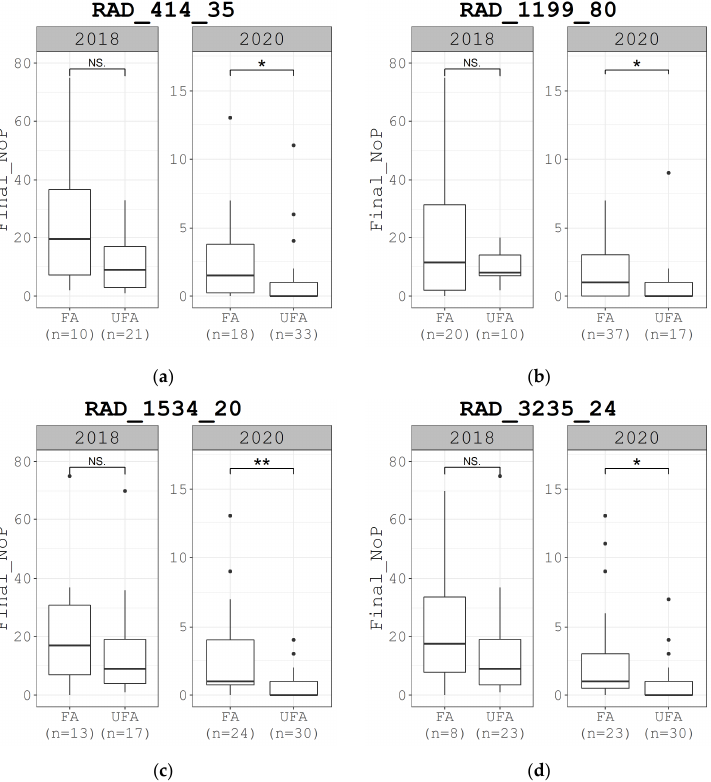
Agronomy 2022 , 12 , x FOR PEER REVIEW 16 of 23 Figure 6. Boxplots (25–75th percentile; center line, median) showing the phenotypic differences in Final_NoP (final number of pods) between genotypes with favorable alleles (FAs) and genotypes with unfavorable alleles (UFAs) on selected SNPs as observed in glasshouse heat stress trials in 2018 (33 genotypes) and 2020 (64 genotypes). ( a ) RAD_414_35, ( b ) RAD_1199_80, ( c ) RAD_1534_20, ( d ) RAD_3235_24. Significant differences between groups were calculated by Wilcoxon rank-sum test. ** = p < 0.01, * = p < 0.05, NS = p > 0.05.